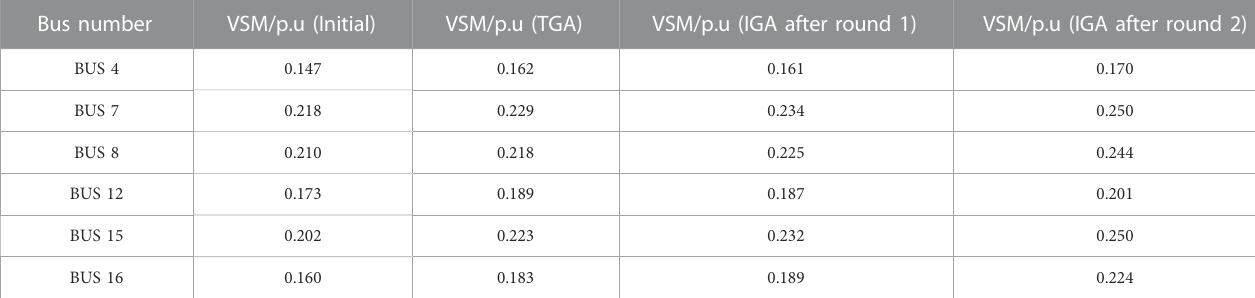
TABLE 4 Effect of Control measures on Voltage Stability margin of fragile bus. Bus